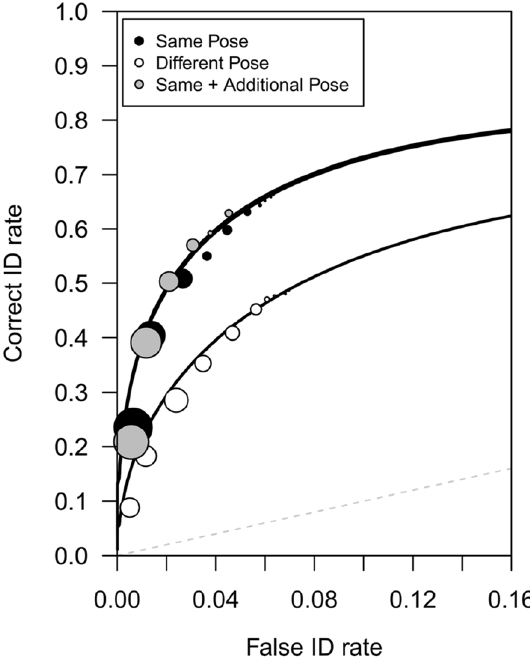
Figure 2. Experiment 1 ROC data in the same pose, different pose, and same + additional pose conditions. The circles are the empirical data and the curved lines of best fit were generated using the Independent Observations model. The bottom x-axis shows the estimated false ID rate of innocent suspects. The dashed line indicates chance-level performance. The size of the symbols represents the number of suspect IDs at a given level of confidence relative to the total number of suspect IDs collapsed across all levels of confidence 31